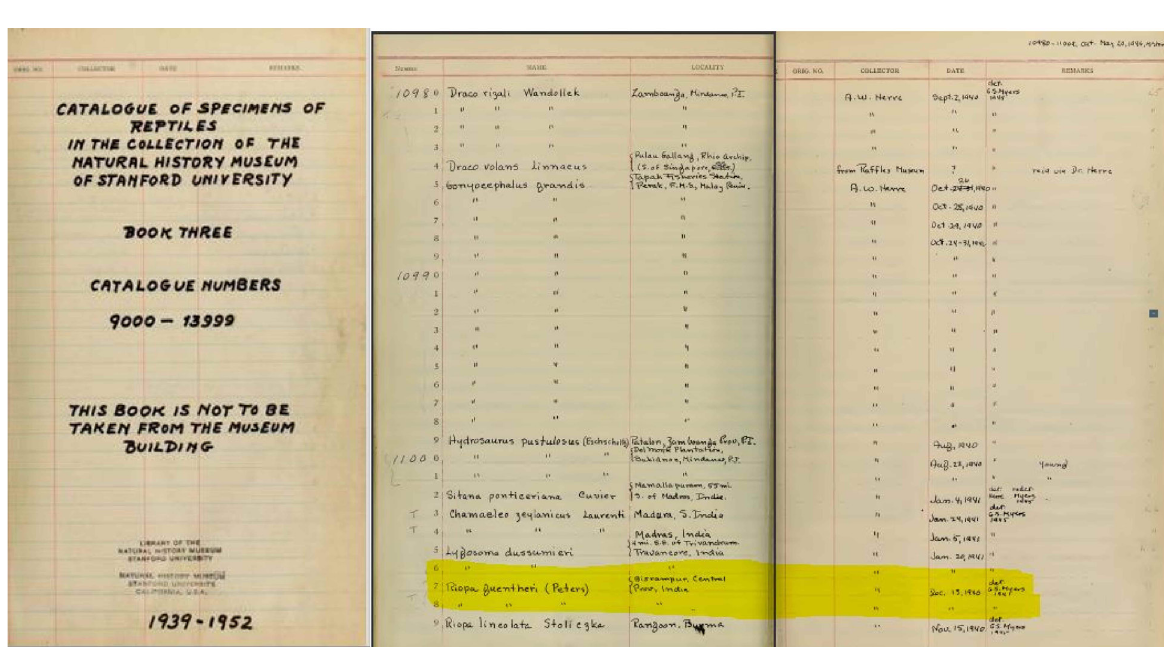
Figure 1. The evidence page of the catalogue showing Lygosoma guentheri specimens in the collection of the Natural History Museum of Stanford University’ (California Academy of Science, Herpetology Collections,